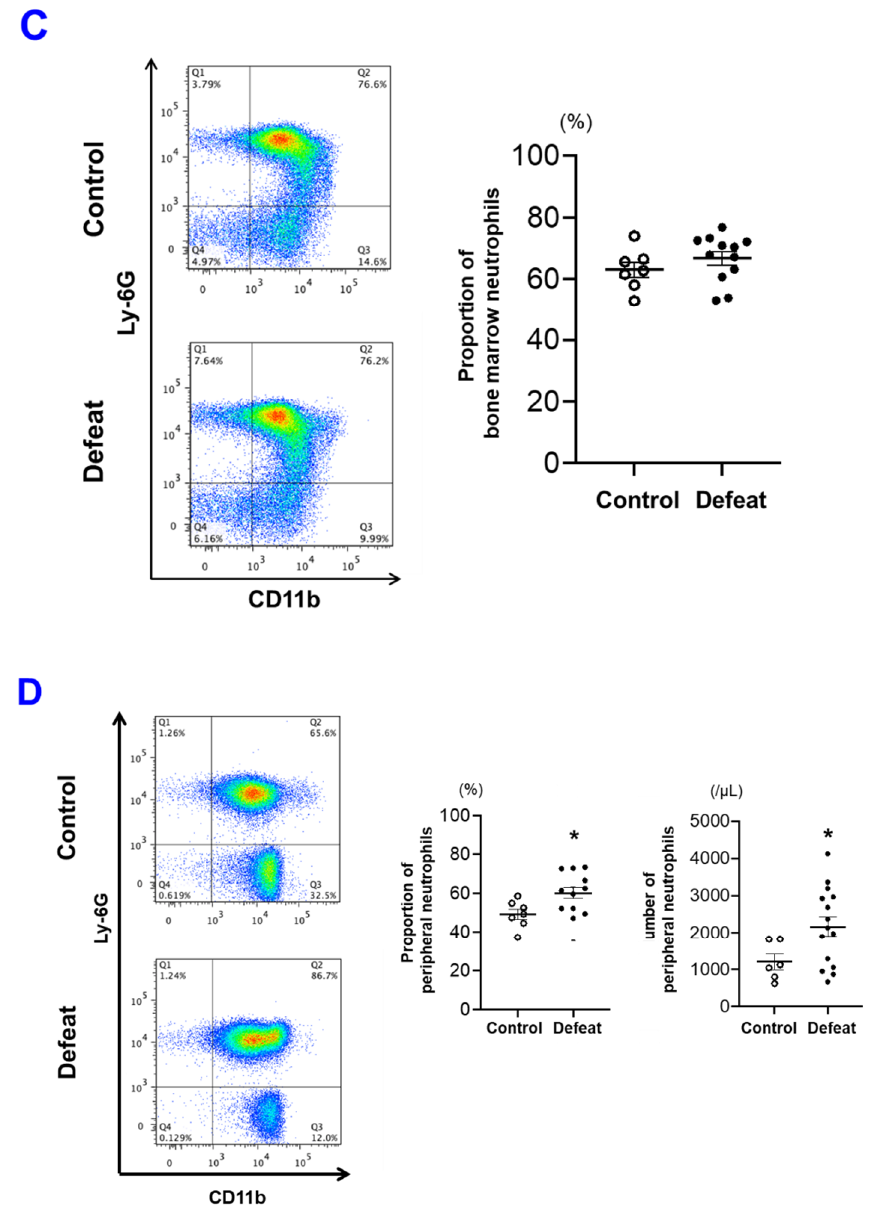
Figure 5. RSD does not affect the number of PB neutrophils before FeCl 3 application. ( A , B ) The number of PB neutrophils was similar between control and defeated mice. Values represent mean ± standard error of mean (SEM) for five control and seven defeated mice for BM neutrophils ( A ) and PB neutrophils ( B ). ( C , D ) The number of PB neutrophils after FeCl 3 application was significantly increased in defeated mice. Values represent mean ± standard error of mean (SEM) for 7 control and 15 defeated mice for BM neutrophils ( C ) and PB neutrophils ( D ). * p < 0.05 vs. control mice; Student’s t -test. BM, bone marrow; PB, peripheral blood.